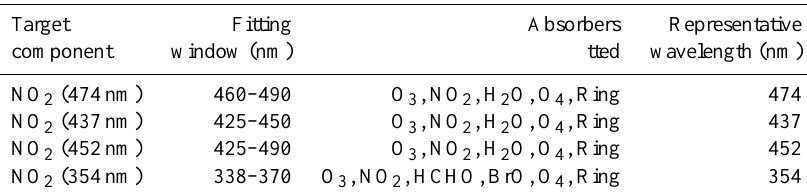
Table 1. Fitting windows and absorbers fitted in DOAS analysis. The representative wavelength for each target component is the cross- section-weighted mean wavelength over the fitting window.